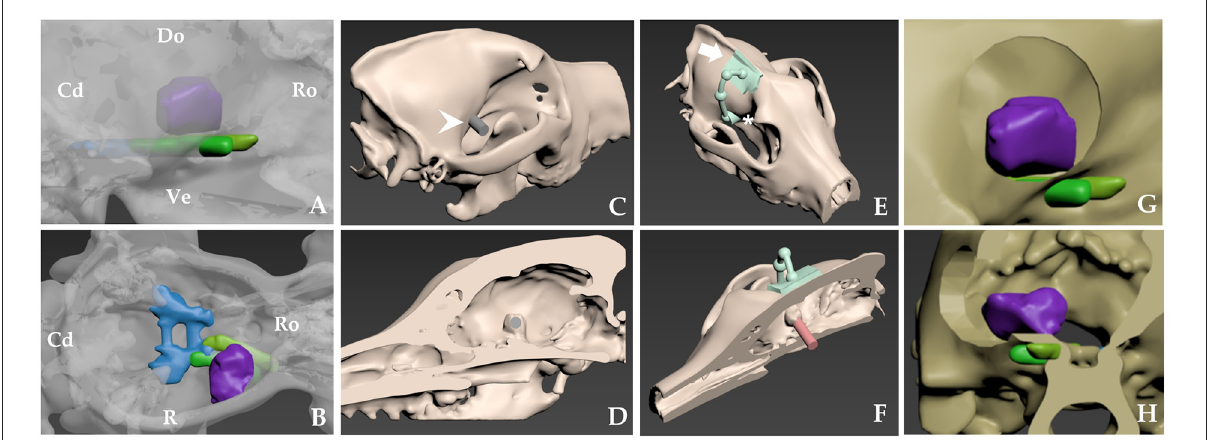
FIGURE2 Schematic images of the approximate location of tumor-related neurovascular structures and pre-operative skull-contoured three-dimensional (3D) patient-specific pointer (PSP) design process for craniectomy of a right sphenoid-wing meningioma. (A,B) Skull rendering is based on computed tomography (CT) scans. Tumor, purple; middle cavernous sinus, blue; optic nerves, yellow; orbital-fissure nerves, including the oculomotor nerve, the trochlear nerve, the ophthalmic nerve, and the abducens nerve, green. (C,D) The tumor is confirmed in a 3D bone model with a sagittal cut of the head. A 3D tumor-targeting gray cylinder (white arrowhead) the same size as the tumor passes through the sphenoid-wing bone representation. (E) The attachment arm (white arrow) and pointer (asterisk*) are shown. The diameter of the pointer is twice that of the gray cylinder (C,D) . (F) Attachment of the bone model and the PSP at the sagittal plane indicates the tumor’s location. The red cylinder shows the relationship between the PSP and the tumor. (G,H) After the craniectomy, the expected relationship of surgical window and nerves in lateral (G) and transverse images (H) . Cd, caudal; Do, dorsal; Lt, left; Ro, rostral Rt, right; Ve, ventral.